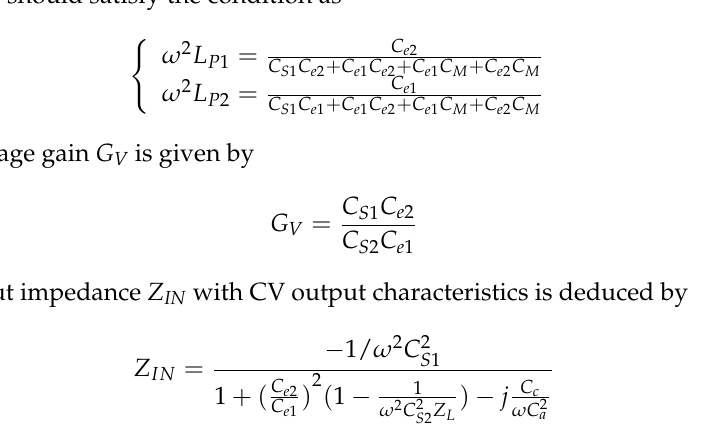
Figure 9. CL − LC compensation topology with π -type coupler model.